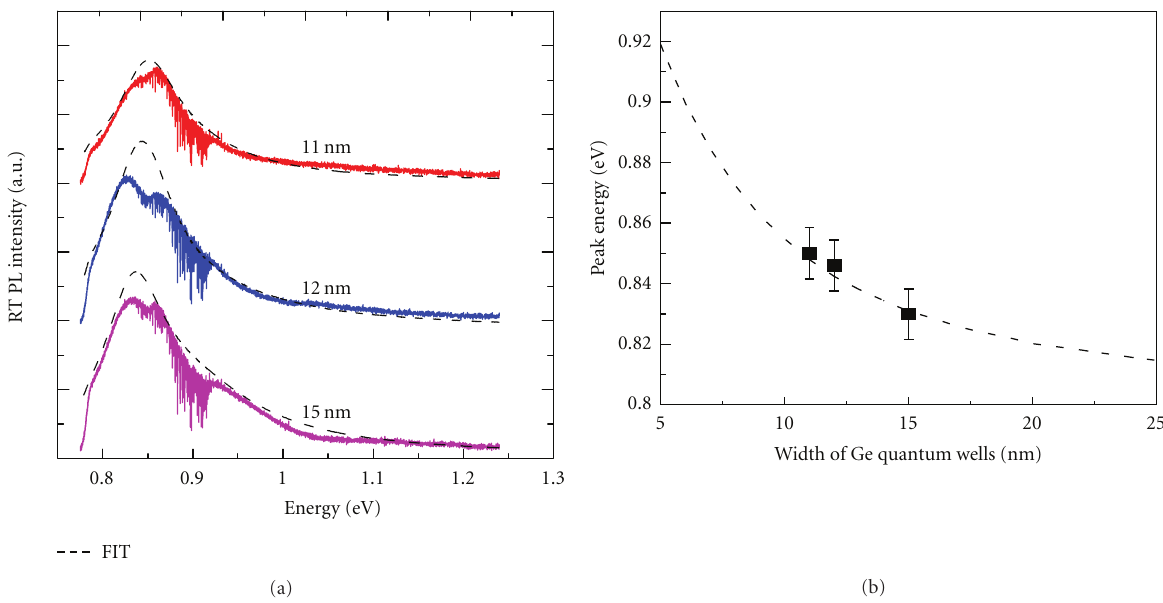
Figure 11: (a) Room temperature photoluminescence of the tensile-strained Ge/SiGe MQW of the samples; (b) dependence of photoluminescence peak energy on the thickness of Ge well layer. The calculated direct band transition energy due to quantum confinement e ff ect at Γ point is plotted as dashed